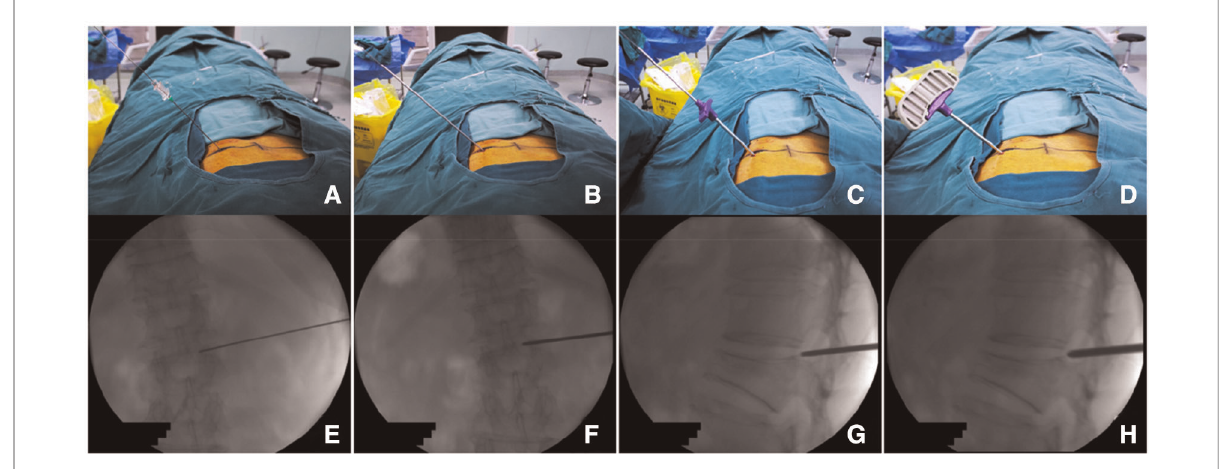
FIGURE 3 Procedure of percutaneous puncture to the bony entry point. ( A ) puncture needle puncture positioning to P point and local anesthetic injection; ( B ) puncture sleeve replacing the puncture needle; ( C ) working sleeve replacing the puncture sleeve; ( D ) after anchoring the bony entry point, replacing it with a Jamshidi needle to further enter into the vertebral body. ( E – H ) Represents the situation monitored by x-ray during